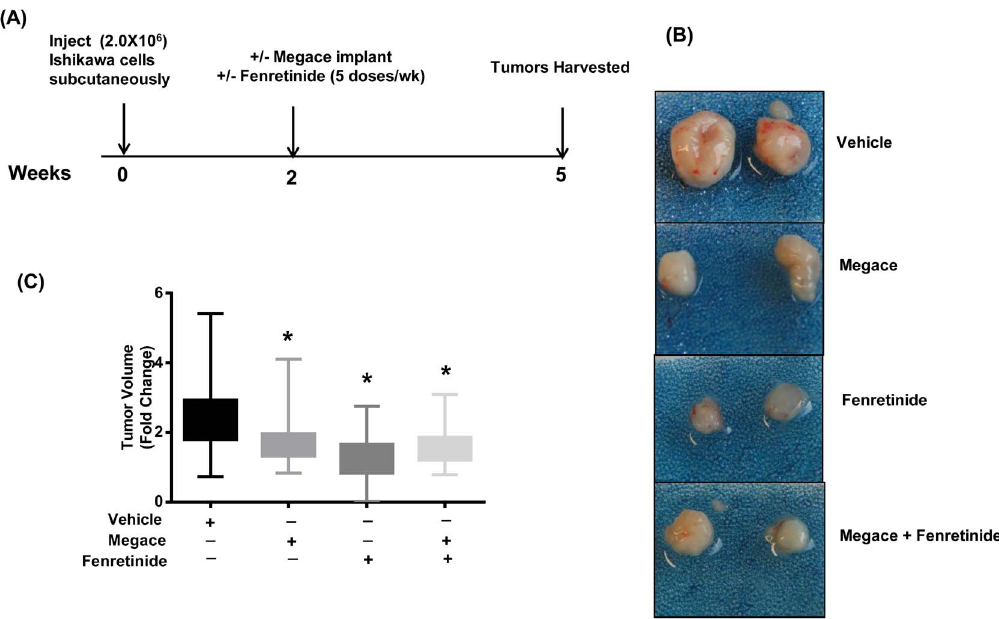
Figure 5. Effect of fenretinide on endometrial tumor progression in an Ishikawa xenograft mouse model (A–C). ( A ) Ovariectomized nude CD-1 female mice were injected with Ishikawa cells in both the flanks and estrogen pellets were implanted. Tumors were allowed to grow for 2 weeks. After 2 weeks of tumor establishment, the mice were treated with vehicle (20 mice), megace (19 mice), fenretinide (21 mice) or megace + fenretinide (20 mice) and tumors were harvested after 3 weeks of treatment. ( B ) Images of representative excised tumors from each group. ( C ) The fold change in tumor volume (from day 1 treatment to day of sacrifice) of vehicle, fenretinde, meagce or both fenretinide + megace treated mice was plotted after 3 weeks of treatment. Data are shown as means 6 min to max of two different experiments. The P values indicate a significant inhibition by fenretinide, megace or megace + fenretinide both on tumor growth (*P , 0.05). The largest decrease in tumor size was observed in the mice treated with fenretinide alone.